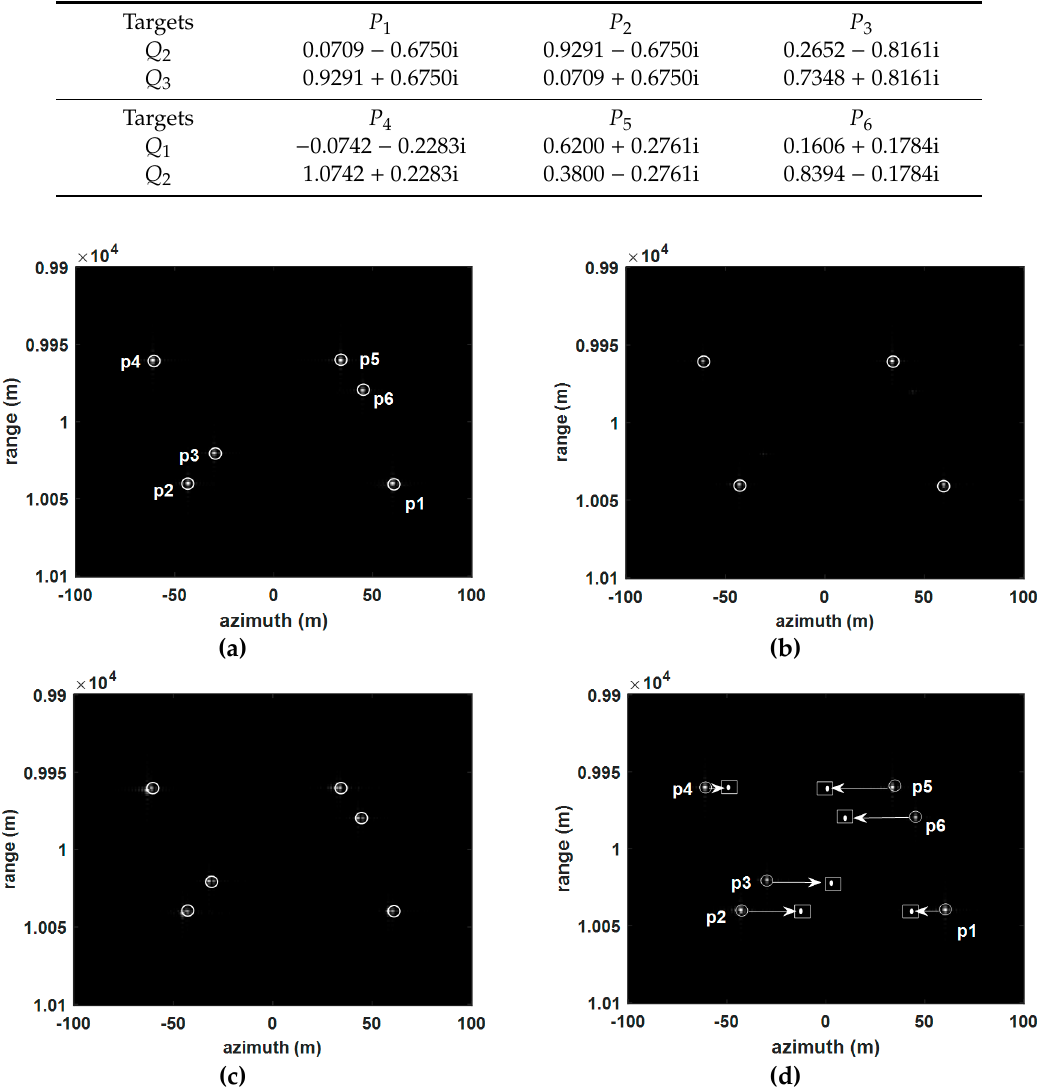
Figure 7. Simulations of false targets generated by two transponders. ( a ) is the SAR image of channel A 2 ; ( b ) is the result of the channel A 2 and A 3 DPCA operation; ( c ) is the result of the channel A 1 and A 2 DPCA operation; ( d ) is the relocation result.